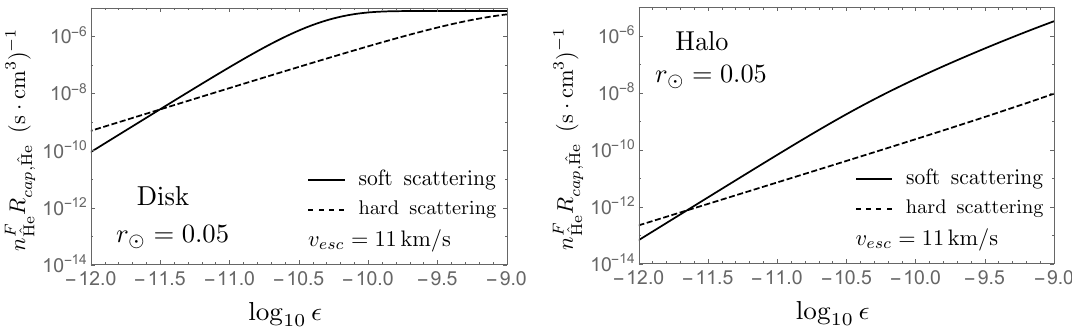
= 0 . 05 . This plot assumes (cid:12)